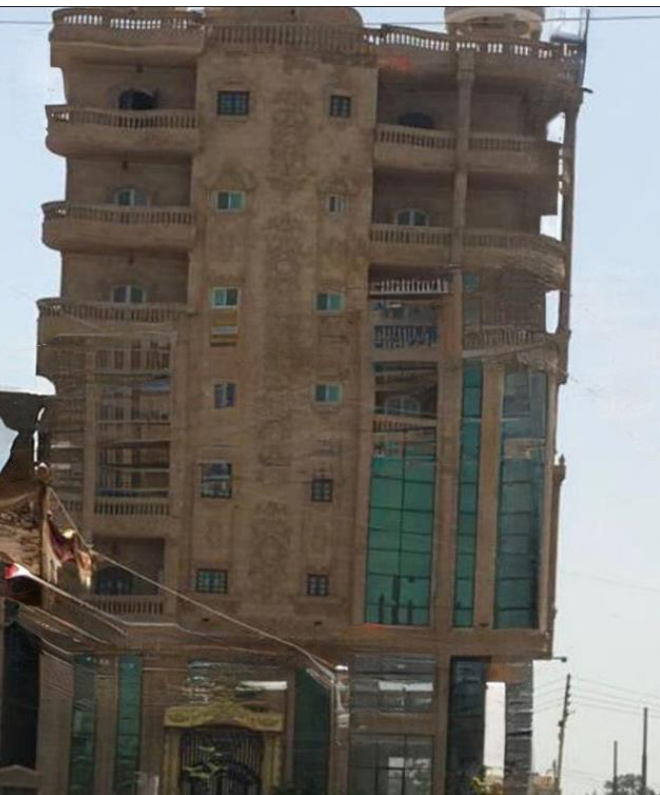
Figure 2. A photograph of the tilted building from the southern side.